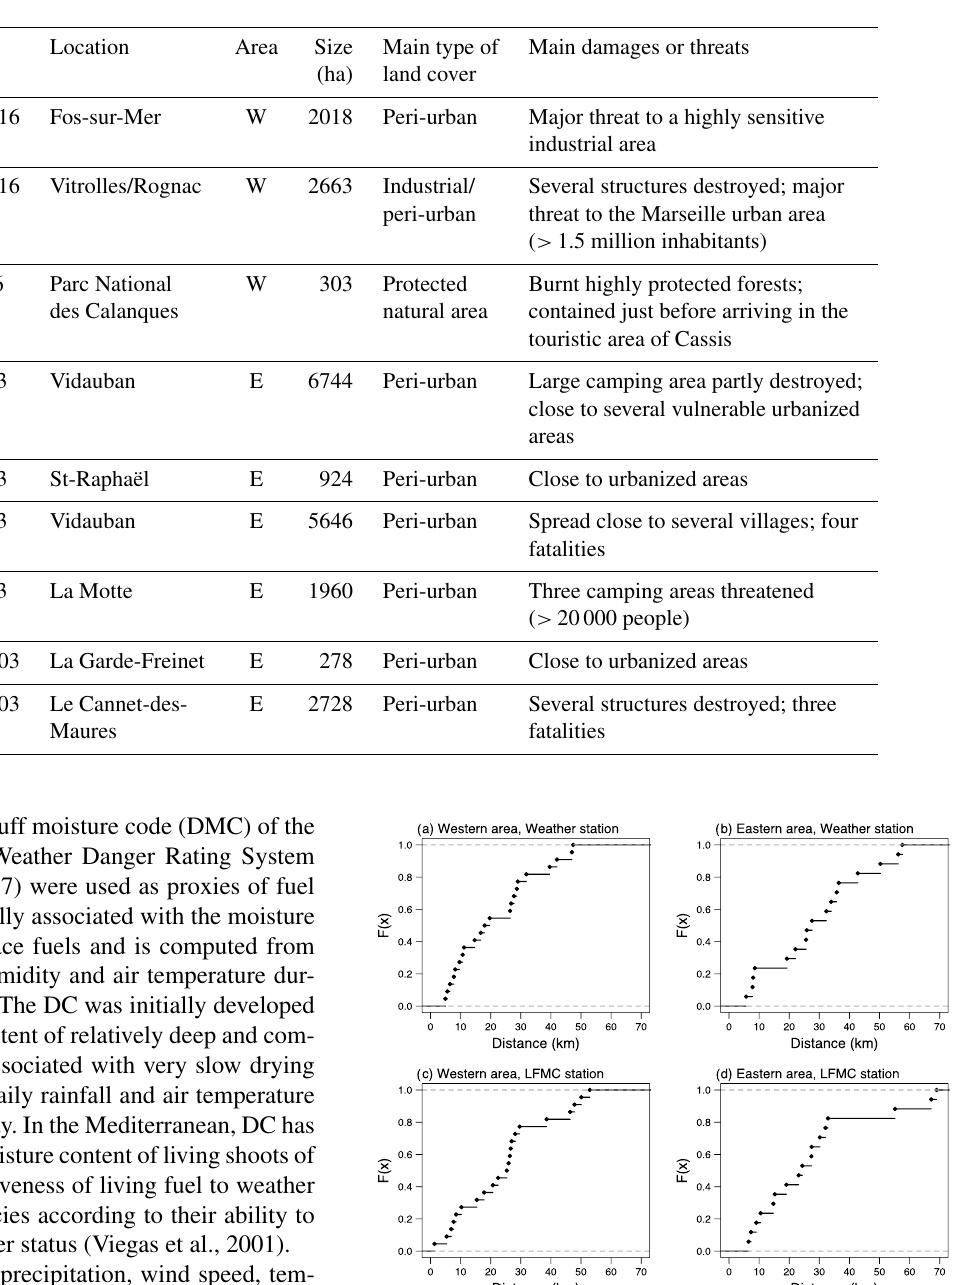
Table 1. Description the extreme wildfires that occurred in Mediterranean France during the summers of 2003 and 2016.